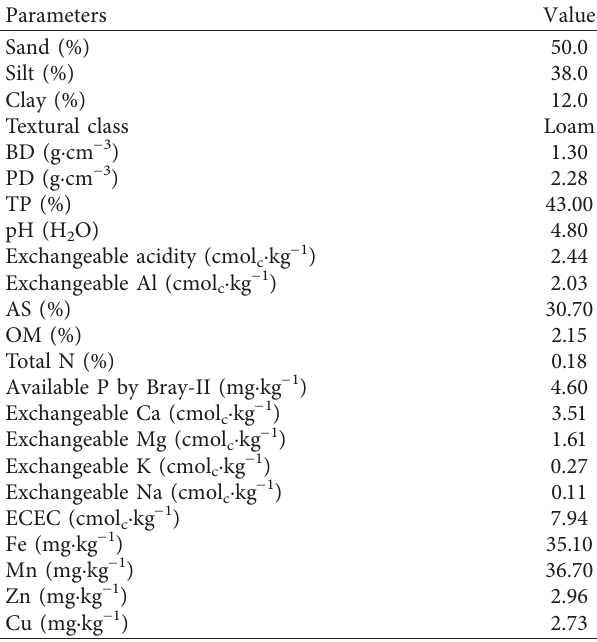
Table 1: Selected physical and chemical properties of the exper- imental soil before incubation.